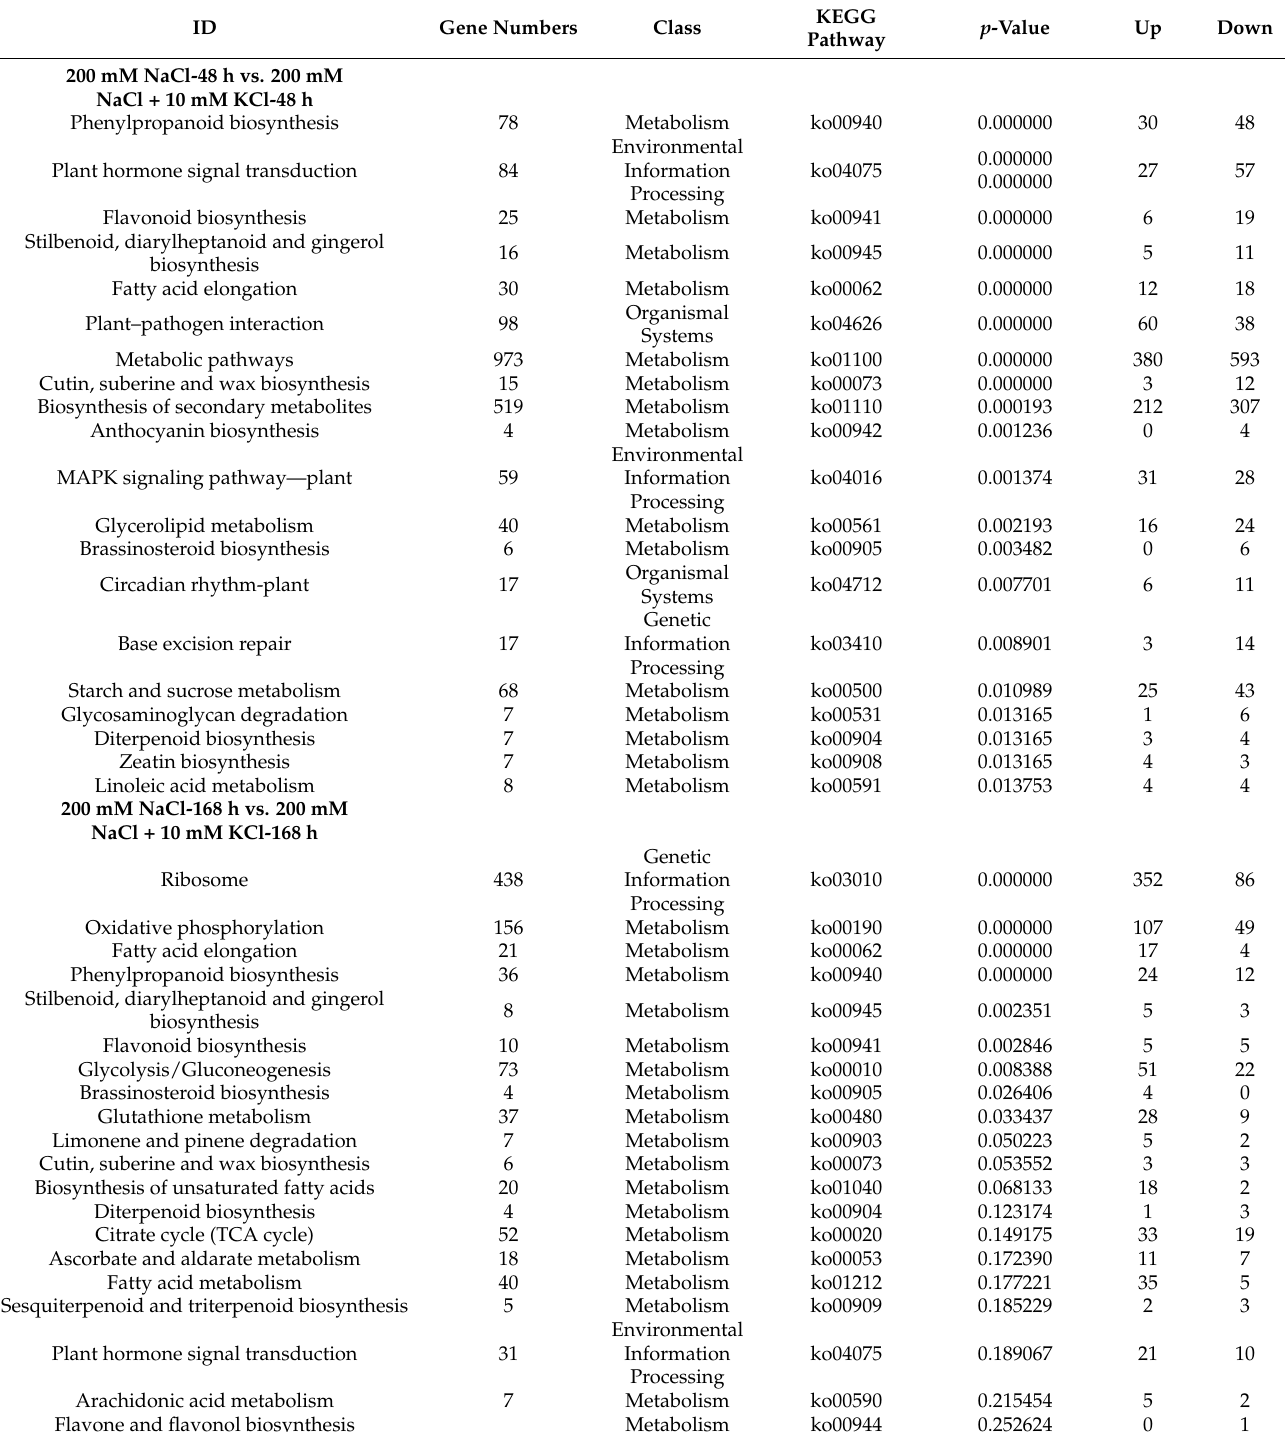
Table 1. Annotation of DEGs in the top 20 KEGG pathways of T . ramosissima leaves under NaCl stress with exogenous potassium (K +